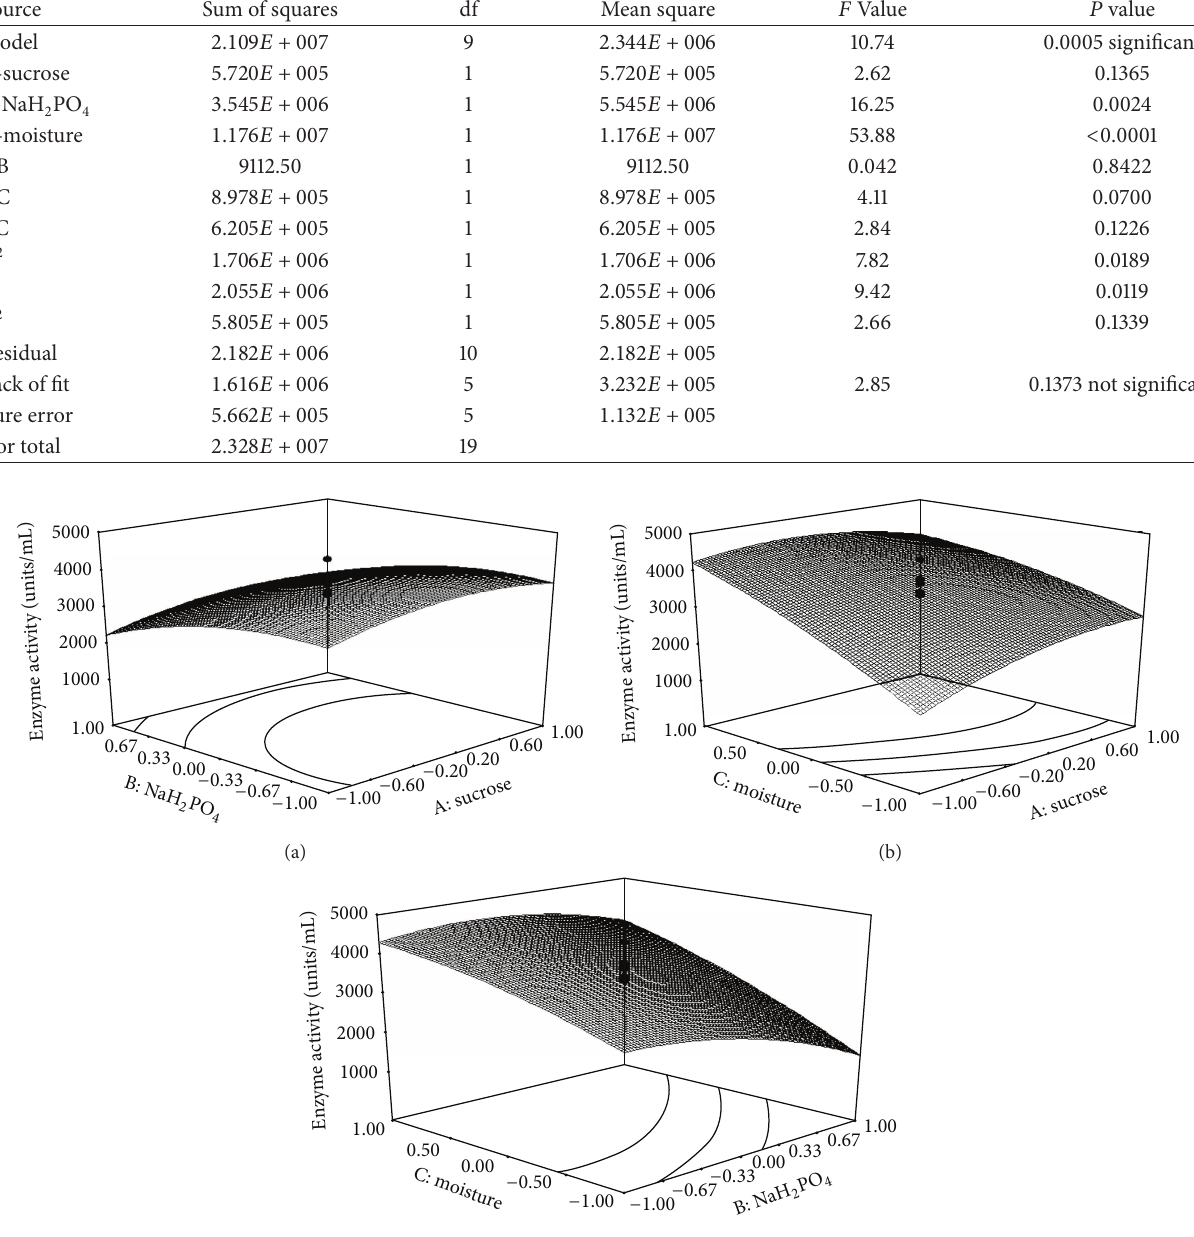
Table 5: ANOVA for response surface quadratic model.